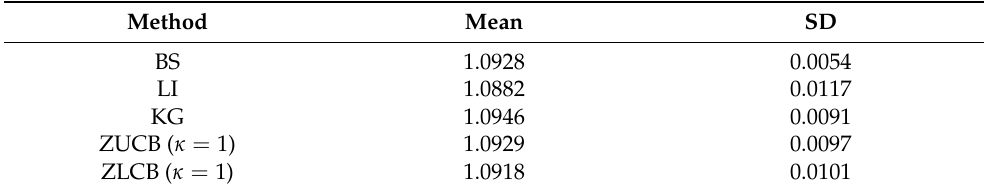
Table 5. Means and SDs for optimal values ( ˆ x ): viable optimisation methods: 25 runs each, interval I = [ 0,1.5 ]